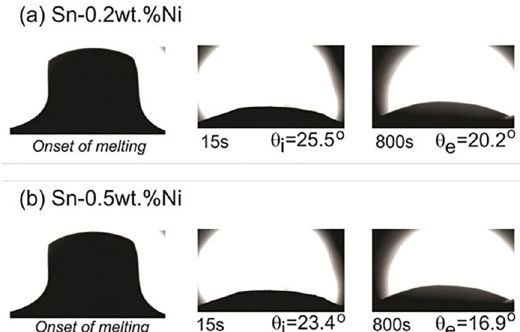
Figure 12. Advancing contact angles of the Sn-Ni droplets on AISI 1020 steel surface showing the initial, θ for the (a) Sn-0.2wt.%Ni and (b) Sn-0.5wt.%Ni alloys be seen in the inserted SEM microstructure in Fig.